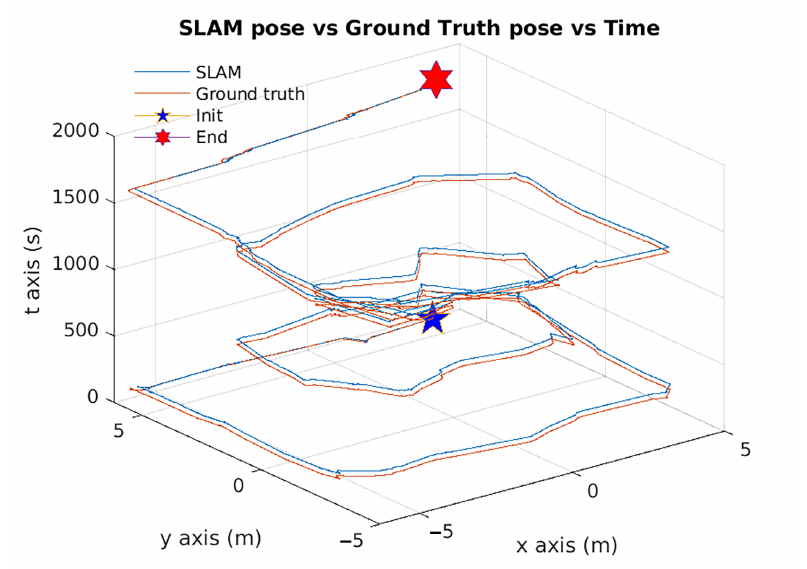
Figure 24. Pose error evolution for KARTO-SLAM on observation